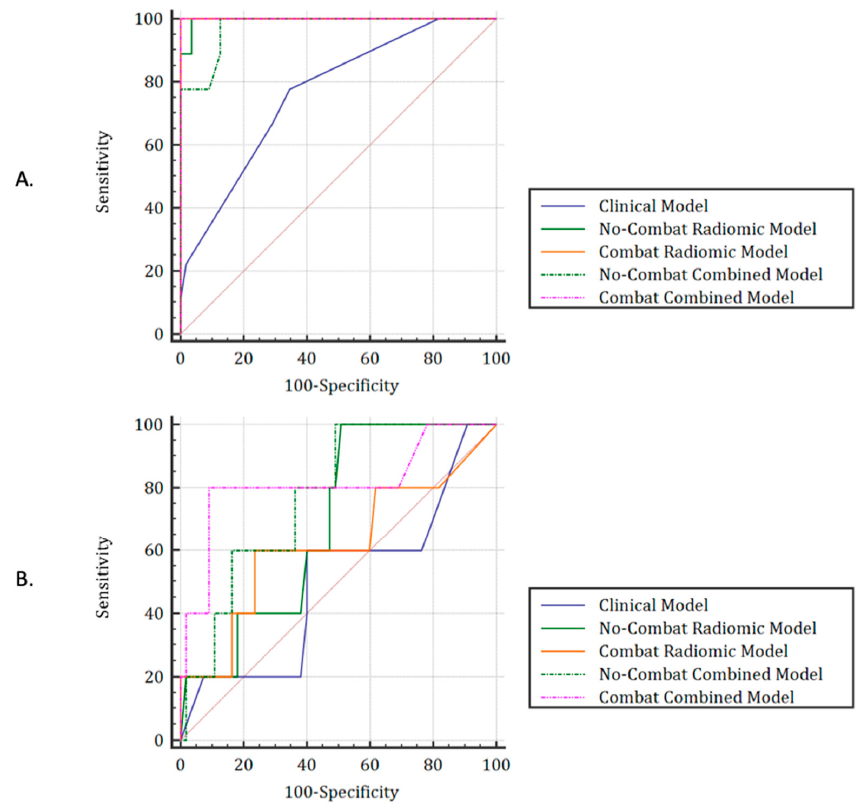
Figure 2. ROC curves for each model in the training ( A ) and testing sets ( B ). Table 3. Results of each model in the testing cohort (institution 2).